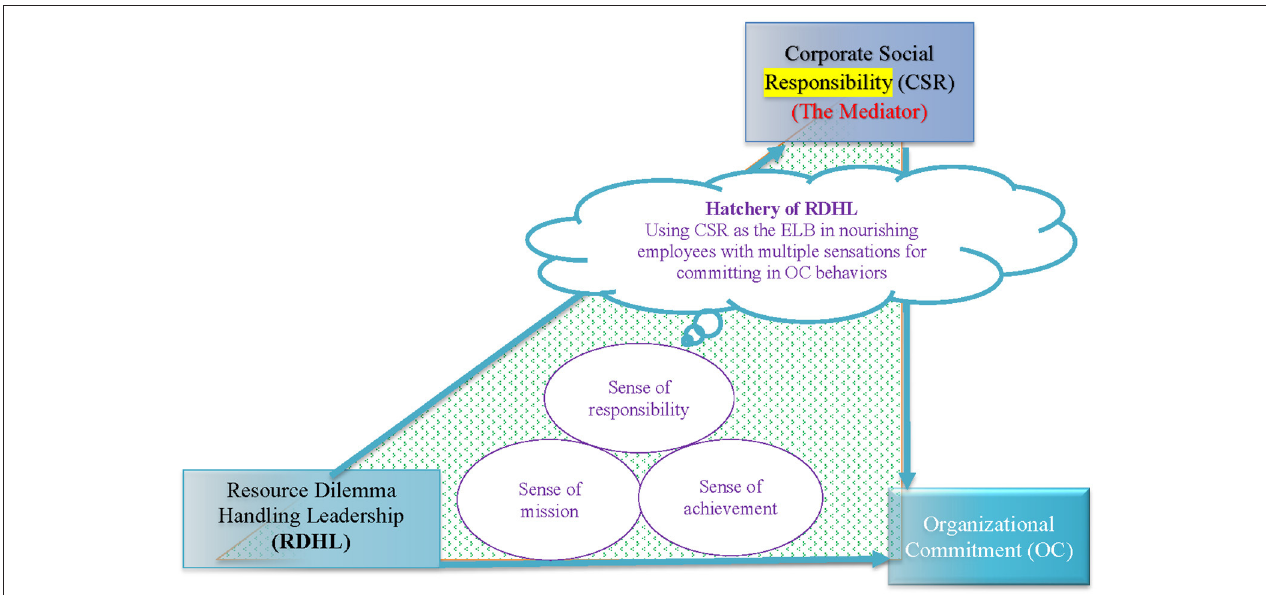
FIGURE 3 | Through the CSR’s hatchery in multiple emotional senses, employees regard CSR as ELB during the process of sustainable development. CSR itself is like a sense of responsibility, giving employees a sense of mission. Because of attaching importance to the sense of mission, employees feel more meaningful and better e to complete the tasks assigned by the organization, resulting in OC. It is like a hatchery, allowing employees to gain a sense of accomplishment in learning the meaning of the mission and completing meaningful tasks in the